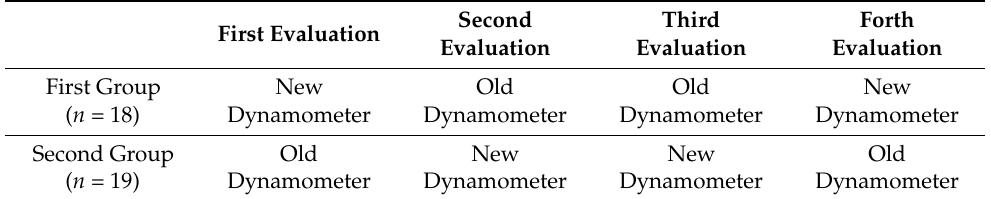
Table 2. The day-dynamometer matches of Isokinetic measurement of the